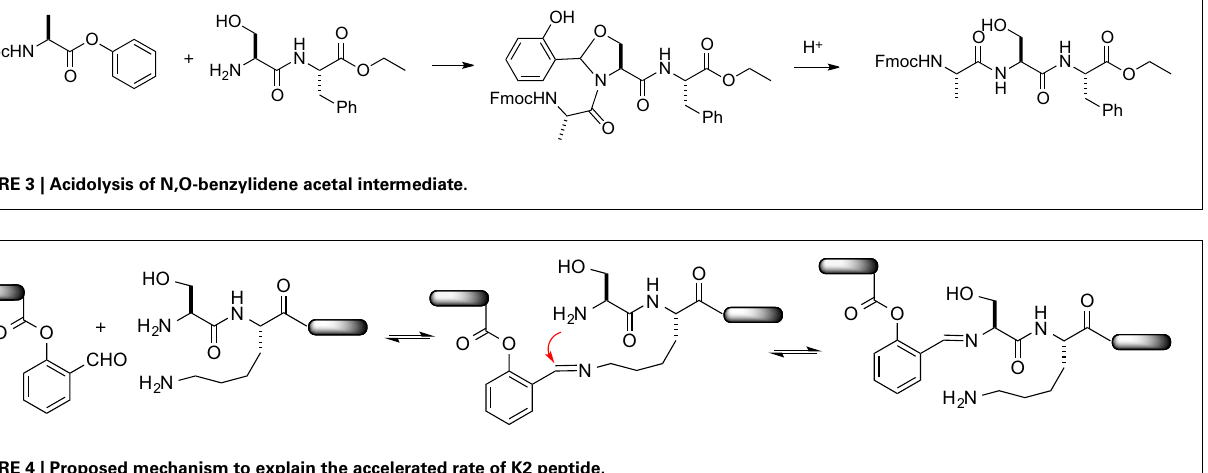
FIGURE 4 | Proposed mechanism to explain the accelerated rate of K2 peptide.